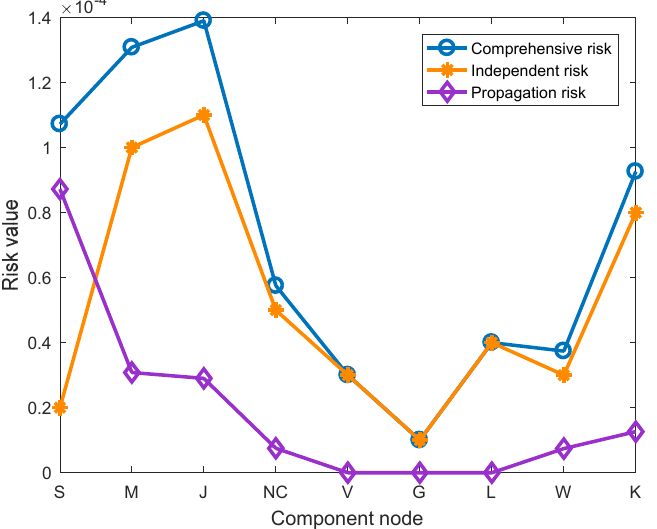
Figure 12. Comparison chart of ranking trends for each risk value of the component at 4000 h.